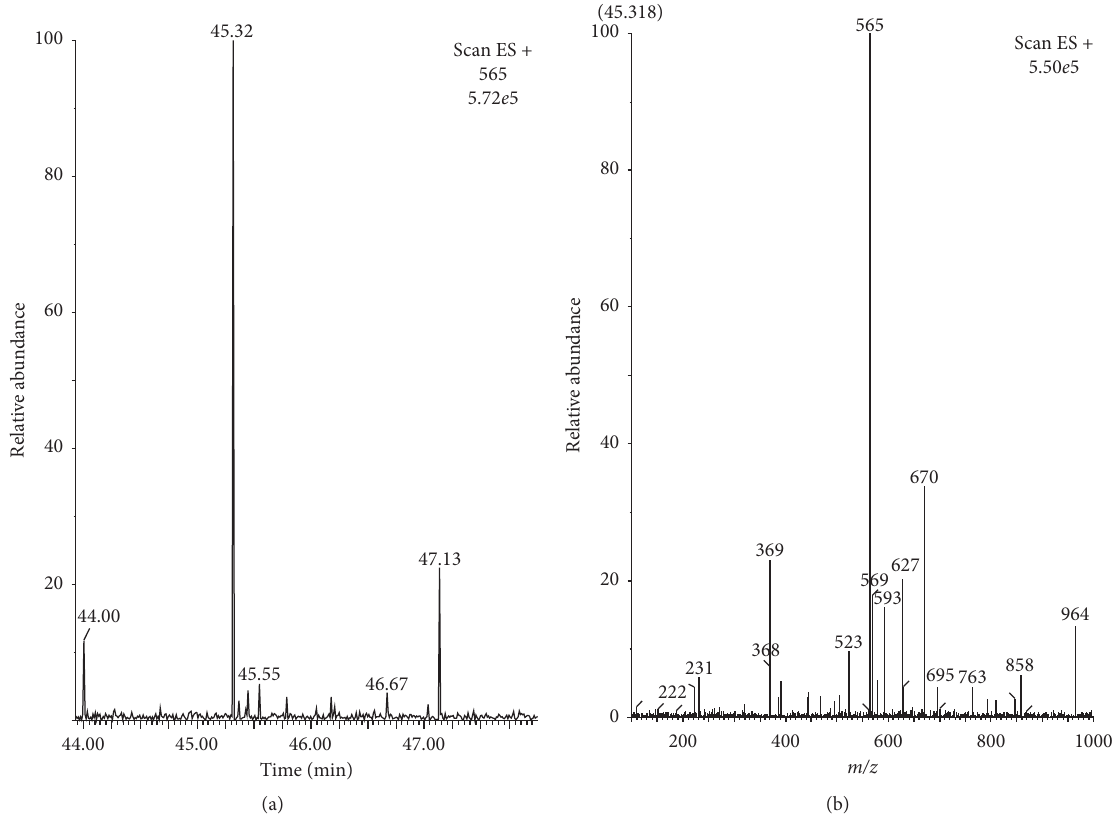
Figure 2: Extracted ion chromatogram (a) and the corresponding mass spectrum (b) based on the protonated molecular ion at m / z 565 that could arise from carbinolamine 7 or the corresponding carbinolamine from secosterol aldehyde 3